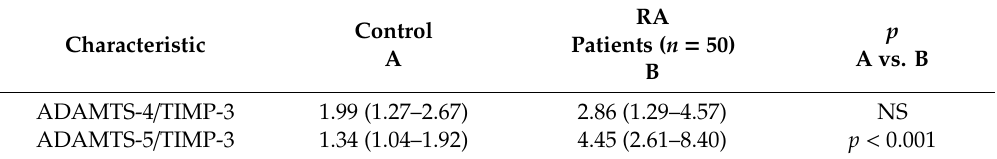
Table 3. Concentration ratios of ADAMTS to TIMP-3 in RA patients before anti-TNF- α therapy and in